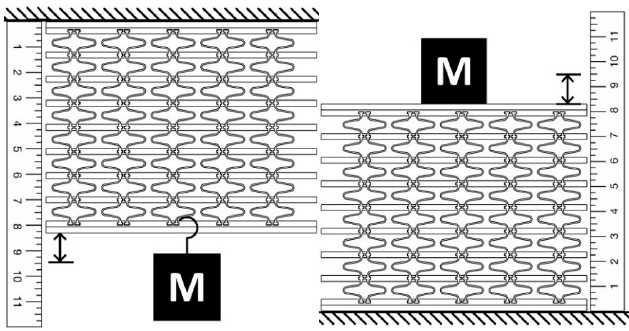
Figure 11. Testing the compliance of the assembled structure.